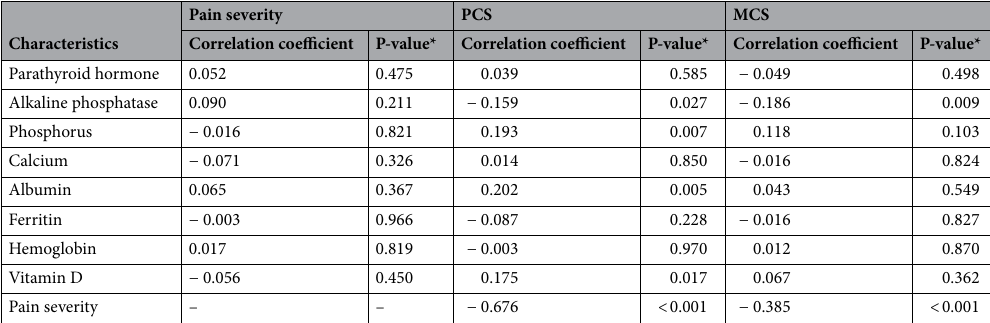
Table 3. Correlation between patients’ Laboratory characteristics and their quality of life and pain severity scores. PCS physical component summary, MCS mental component summary. *Spearman correlation test.